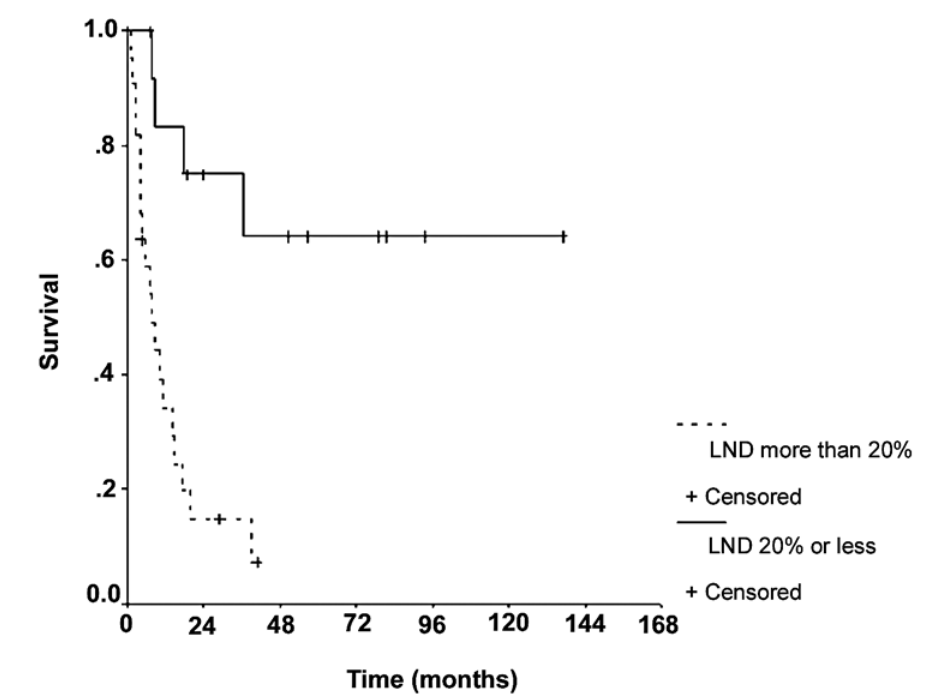
Figure 8 – Disease specific survival by lymph node density in node positive